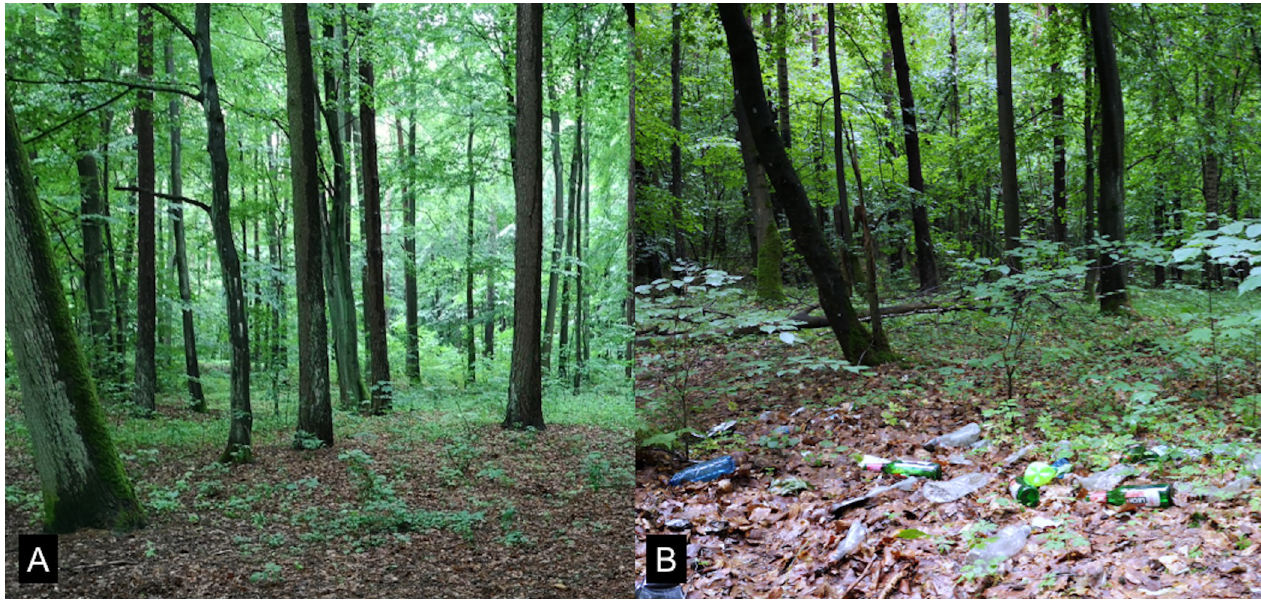
Fig 1. View of control forest (A) and forest with illegal open dump (B). Photos were also reported in Bielinis et al. 2020 [78] (not published).